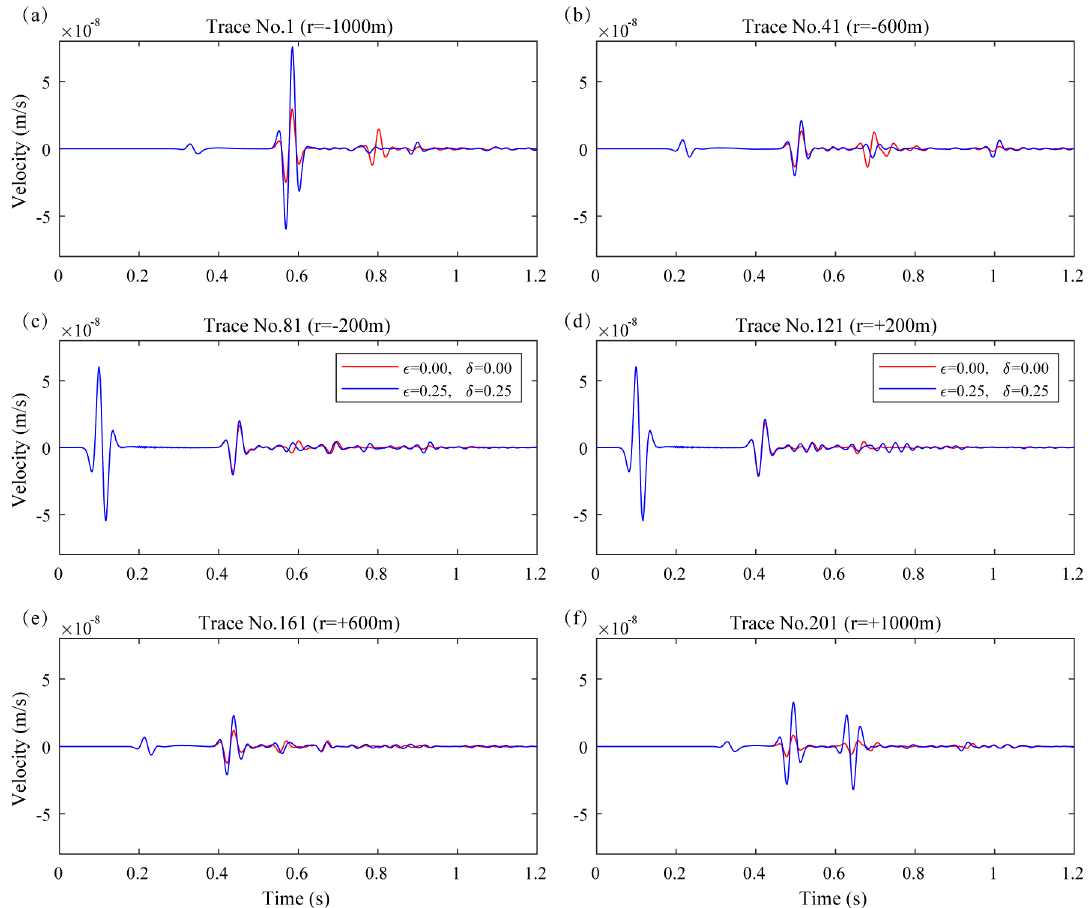
Figure 9. Comparison of Z-component waveforms from model M ED and M 0 (with / without anisotropy, TTI). ( a )–( f ) are waveform records of geophones No.1 / 41 / 81 / 121 / 161 / 201 (with epicentral distance − 1000 / − 600 / − 200 /+ 200 /+ 600 /+ 1000 m, the sign indicates that the detectors are located on two sides of the source, positive along X-axis direction). Red indicates synthetic waveforms from the model M 0 (without anisotropy); blue indicates seismic waveforms from the model M ED (with shale anisotropy).